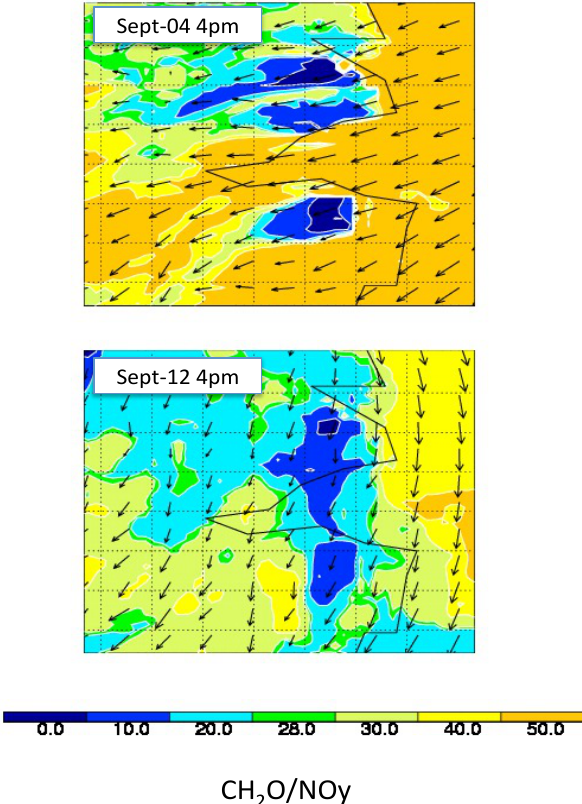
Fig. 10. The calculated ratio of CH 2 O/NO y on 4 September (clean period) and 12 September (polluted period), respectively. When the ratio is less than 0.28 (as indicated by the blue area), the area is un- der the VOC-limited condition for ozone formation, while a higher ratio indicates that the area is under the NO x -limited